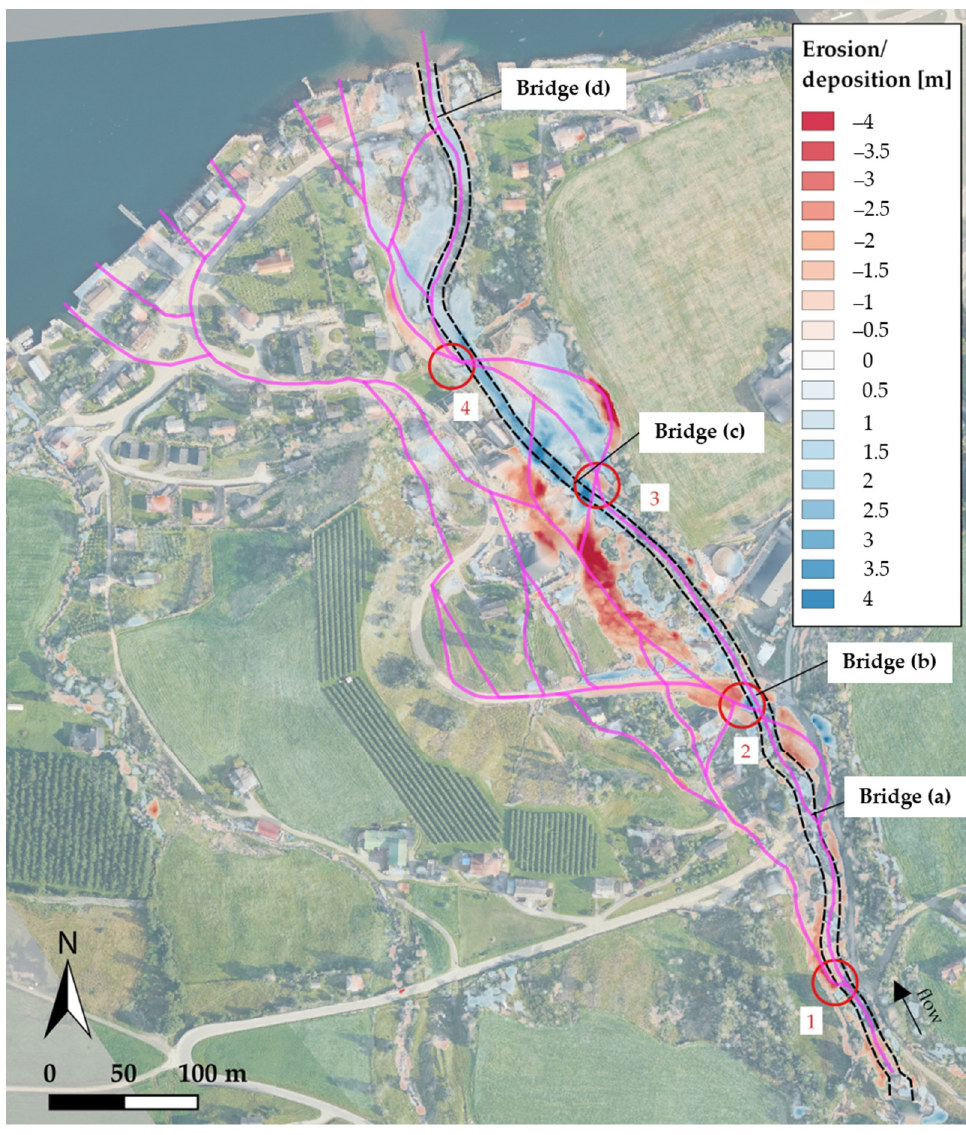
Figure 6. Flow paths and critical points on the erosion and deposition map obtained from pre- and post-flood LiDAR scans. Bridges are labeled ( a – d ); black dashed line represents the original river channel; red circles represent the critical points; purple lines represent flow paths during flood event. Post-event orthophoto from [15].